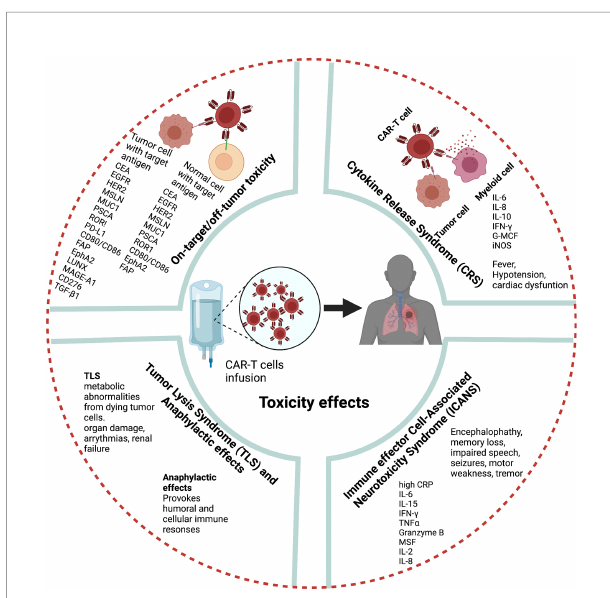
FIGURE 4 | Toxicity hurdles in CAR-T cell therapy (Figure generated using Bio